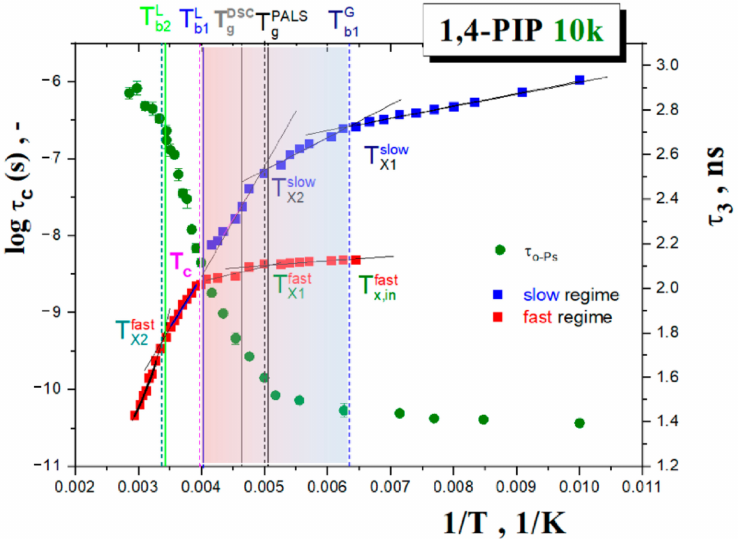
Figure 12. Inverse temperature dependences of time scales log τ c and τ 3 determined for the TEMPO reorientation or o -Ps probe annihilation behavior in cis -1,4-PIP10k, respectively